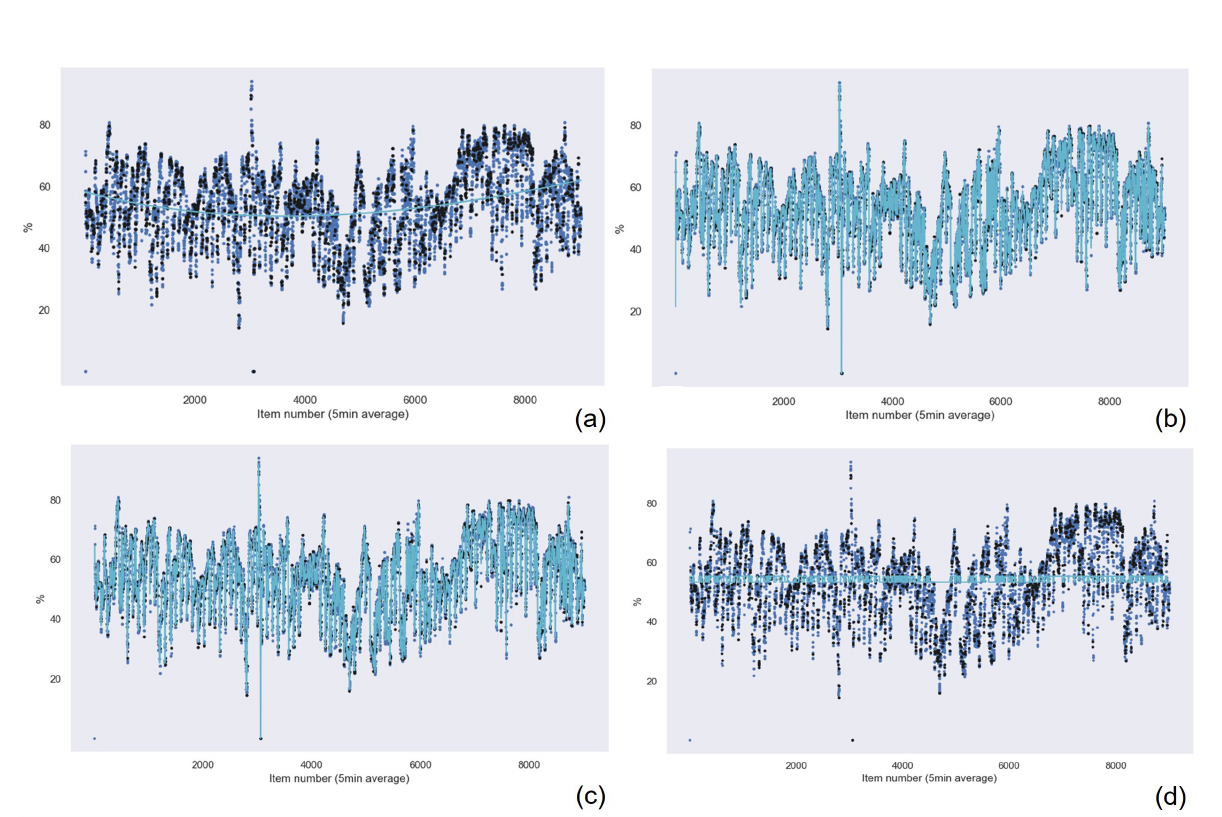
Figure A19. Cont